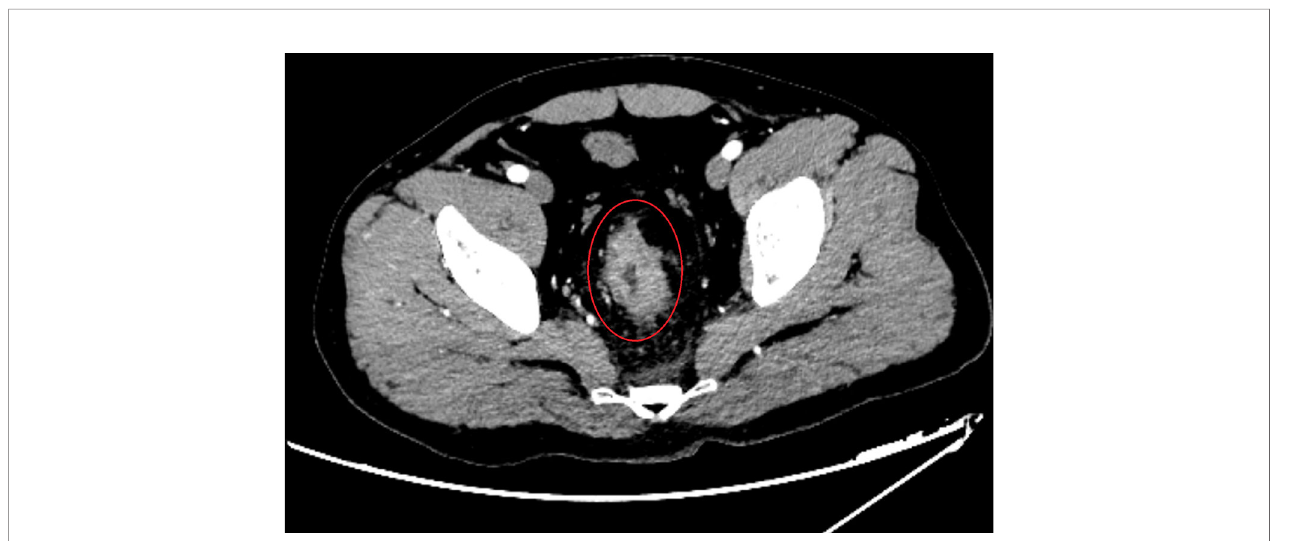
FIGURE 1 | Imaging examinations performed before surgery. Enhanced CT scans on March 21, 2020 of abdomen revealed that occupying lesions in the middle and upper rectum, the intestinal lumen was narrowed, and the serosal layer was hairy. After enhancement, the lesion was uneven and enhanced, and the length of the lesion was about 5.7 cm, considering that was rectal cancer